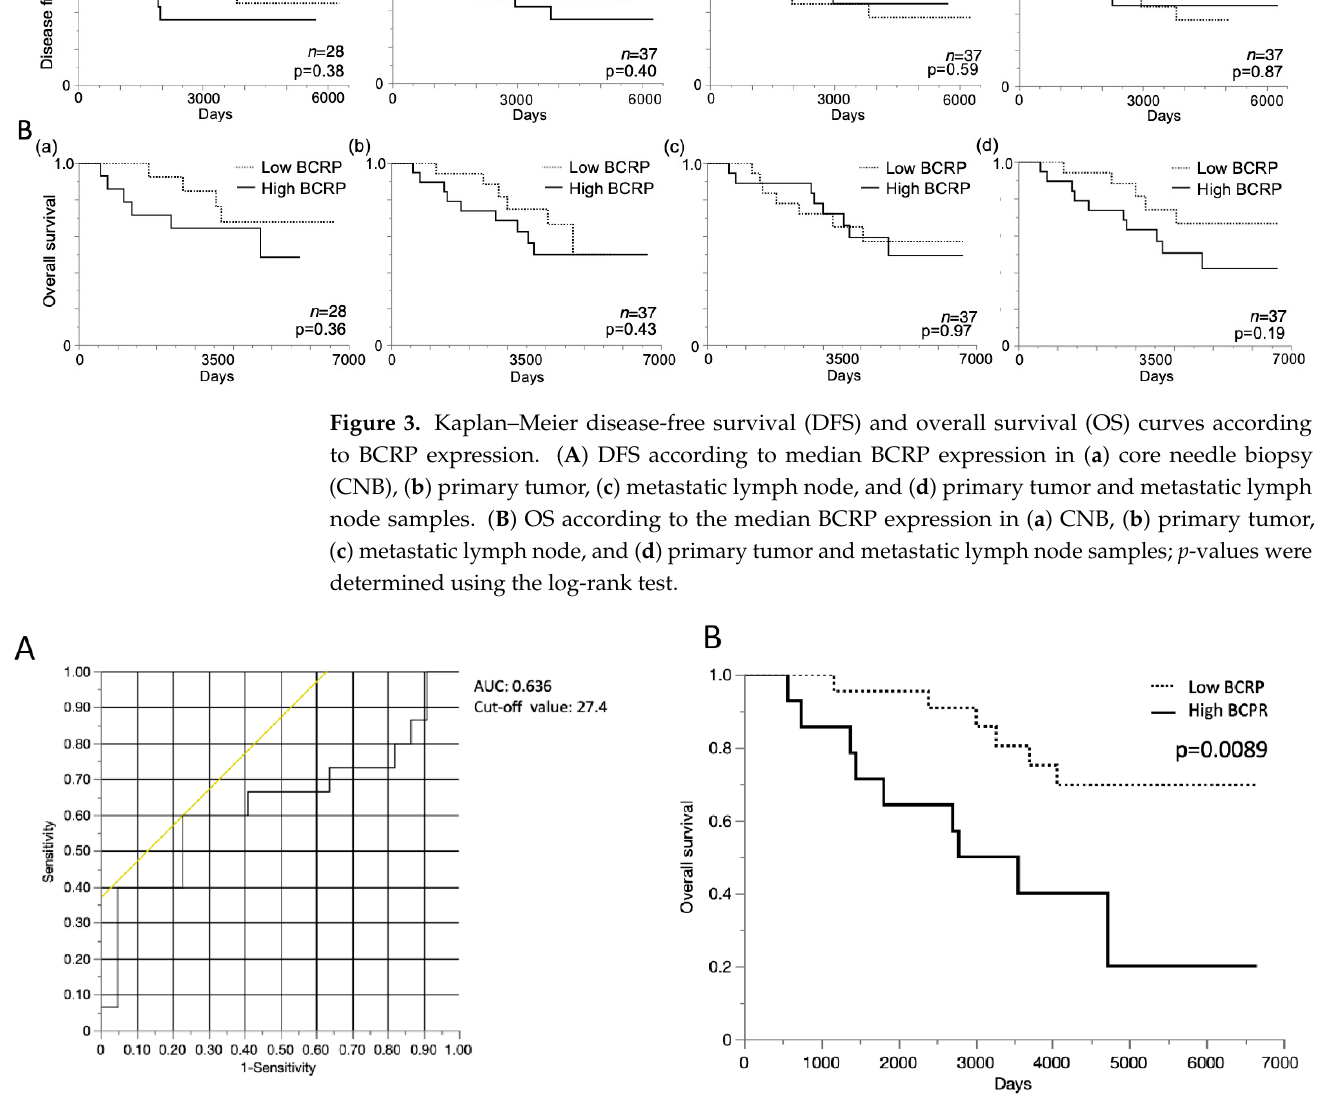
Figure 4. Kaplan–Meier overall survival (OS) curves according to BCRP expression cut-off in primary tumors and metastatic lymph nodes. ( A ) Receiver operating characteristic analysis of the usefulness of BCRP expression in primary tumor and metastatic lymph node samples for predicting death and survival ( n = 37 patients). ( B ) OS curves according to BCRP expression cut-off in primary tumors and metastatic lymph nodes. AUC, area under the curve.